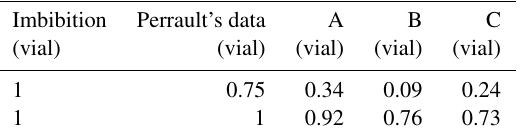
Table 5. Imbibition and percolation volumes measured during the first experiment. Data are reported as the number of vials, in order to make a comparison with Perrault’s data. The unitary volume of a vial was estimated to be equal to 74cm 3 for all the soils, according to Barontini et al. (2013).